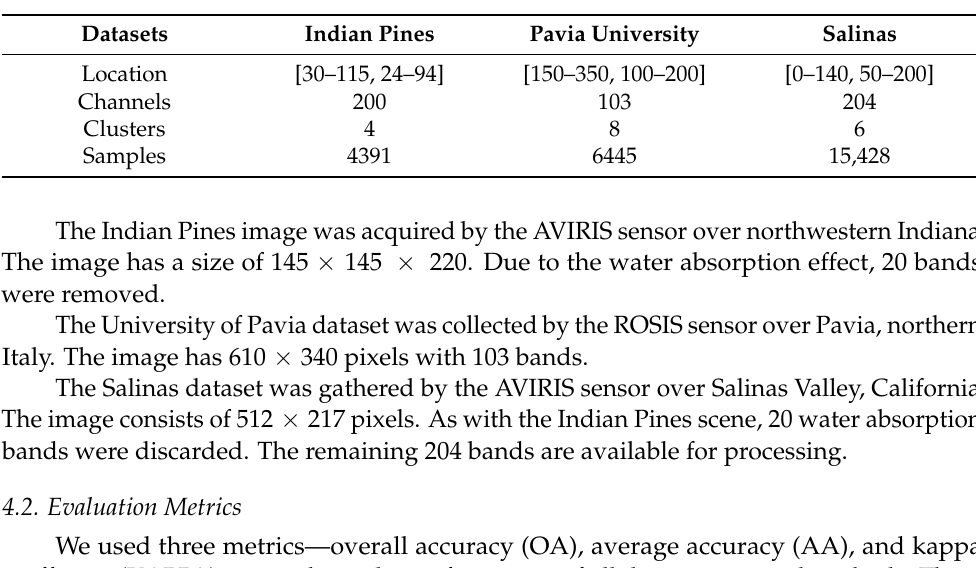
Figure 5. ( a – c ) False-color images of the Indian Pines, University of Pavia, and Salinas data sets. Table 3. Summary of the experimental